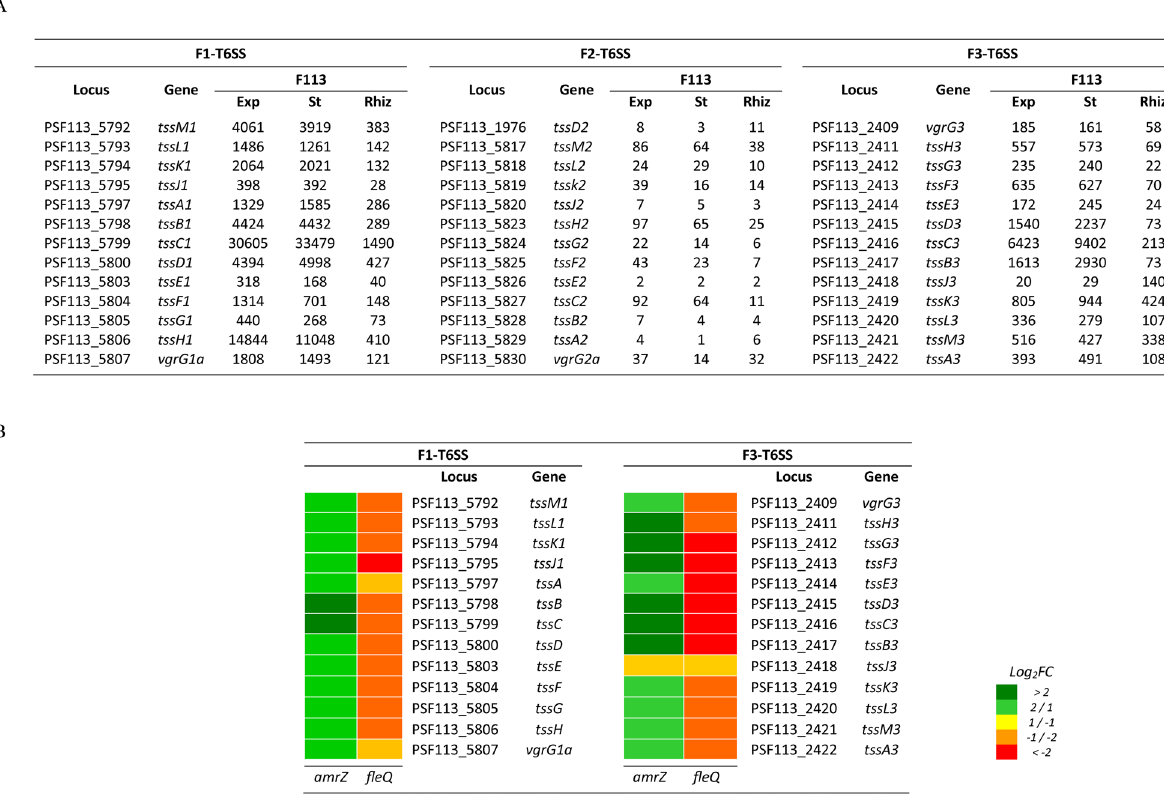
Figure 4. Expression of the P. fluorescens F113 T6SS genes. A.- RNA-seq analysis of the structural and vgrG T6SSs genes under the three different conditions tested. Gene expression values represent read counts normalized following the median of ratios method. Exp. culture in exponential growth phase (OD 600 = 0.6); St. culture in stationary growth phase (OD 600 = 1.2). Rhiz. Bacteria recovered from rhizosphere. B.- Heatmap representation of F1- and F3-T6SS gene expression in the amrZ and fleQ mutants background compared with wild type strain after rhizosphere colonization. Pseudomonas fluorescens F113 annotated genes with a log 2 FC (mutant/wild-type) ≤ − 1/ ≥ 1 are